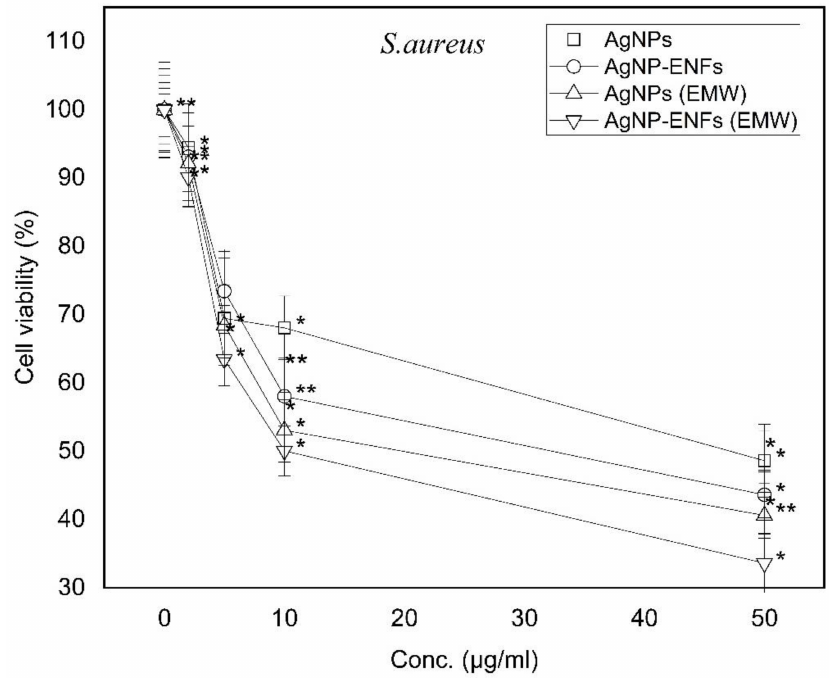
Figure 6. Cell viability percentages of S. aureus relative to control bacterial counts; * statistically significant, ** statistically highly significant.